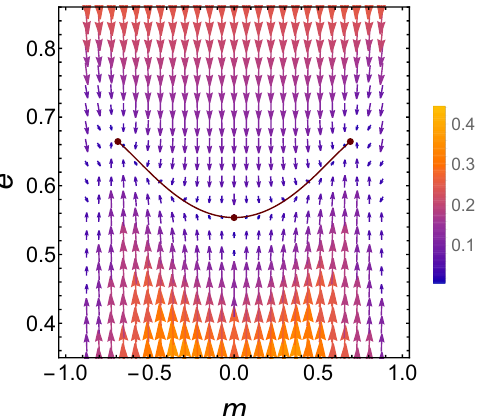
) defined in Eq. (9) as a function of the mag- Figure 2: Plot of the force field ( f , f 1 2 = m and the energy density q = e . The color encodes the amplitude netization q 1 2 of the force. The force vanishes at two stable fixed points with a finite magnetiza- tion m ≈ ± 0.7 and at an unstable fixpoint at m = 0 (red points). The red solid line indicates the pathes from the unstable to the stable fixed points. Parameters: N = 12, γ = 0.9, J = ∆ = 1, J (cid:48) =